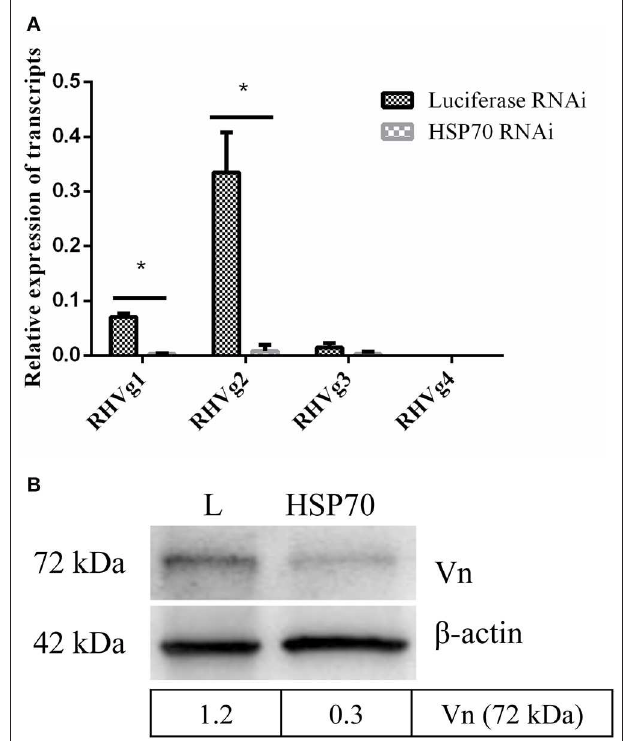
FIGURE 9 | HSP70 gene silencing down regulates expression of Vg and vitellin. RHVg1 and RHVg2 genes decreased significantly in 5-day-fed ticks by real-time quantitative PCR ( A , p < 0.05). ELFIa gene served as the endogenous control. Every group has three biological repeats and each repeat is three times. Data are calculated with 2 − 1 CT . Gene-specific standards were the respective plasmid of RHVg genes. Meanwhile, vitellin protein was down-regulated dramatically at 5 days blood feeding using Western blot ( B , p < 0.05). The intensities of vitellin protein bands (72 kDa) were